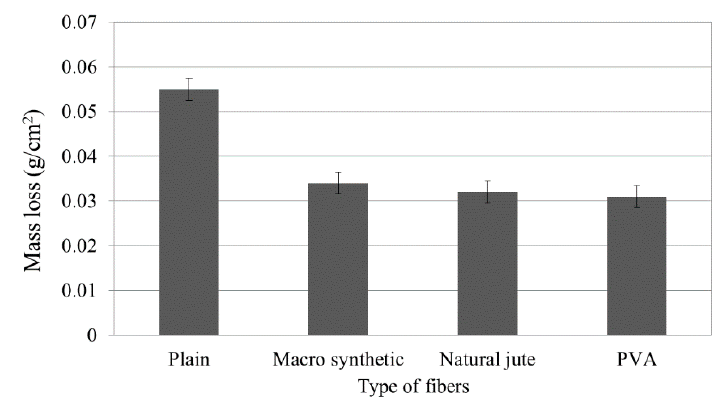
Figure 11. Abrasion test results.